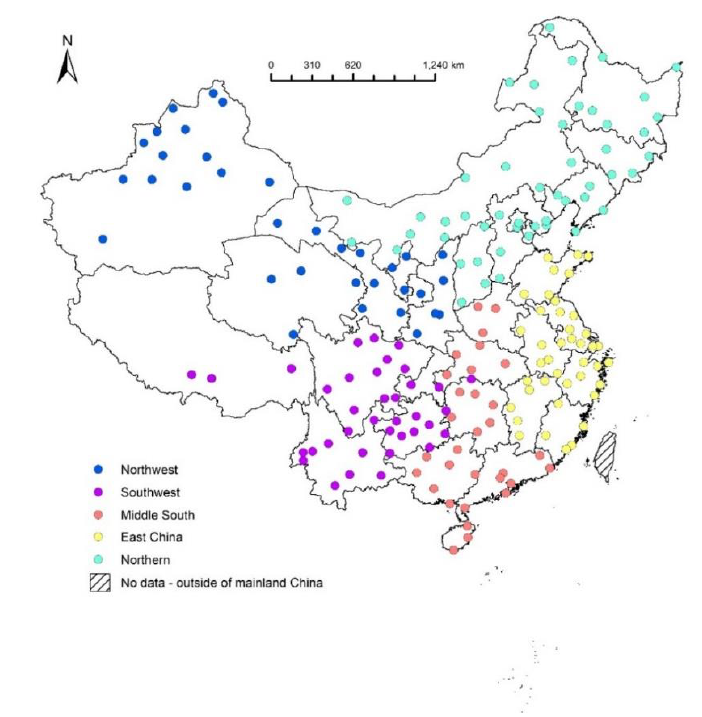
Distribution of multi-airport regions from CAAC Airport classifications under 50km and 90km buffer zones in the Chinese